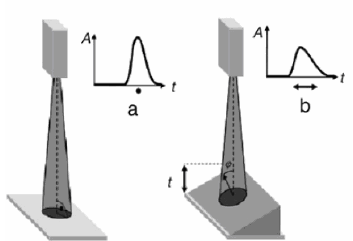
Figure 6. (a) Waveform behavior for a laser beam hits a planar